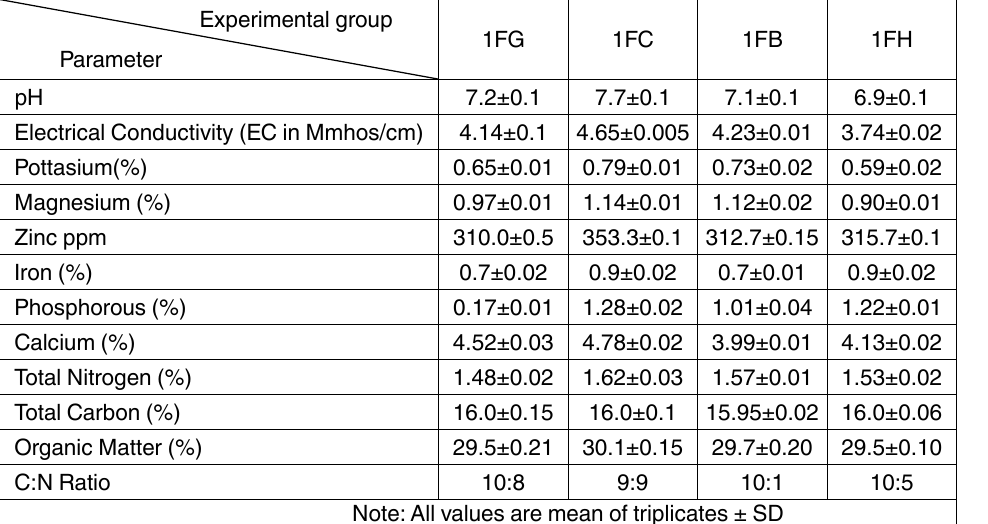
table 2. Physicochemical parameters of the vermicompost harvested from the four experimental